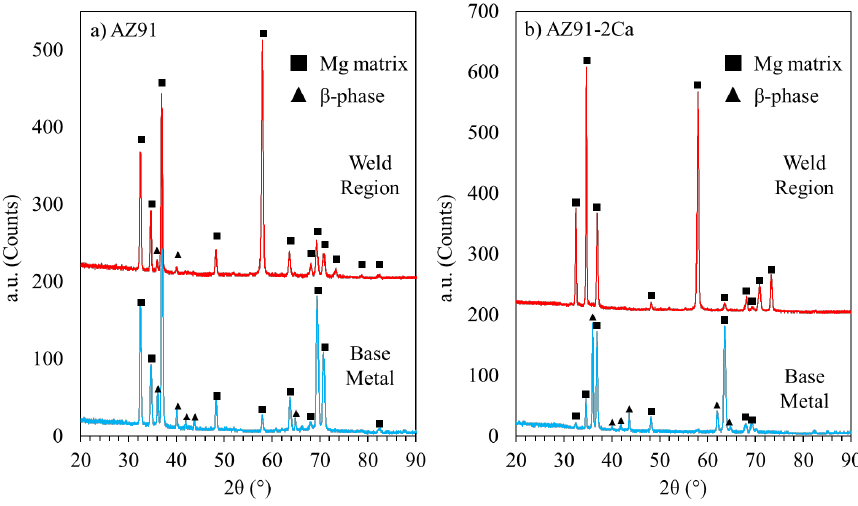
Figure 5. XRD spectra for both the central weld zone and base material in ( a ) AZ91/AZ91 and ( b ) AZ91–2Ca/AZ91–2Ca welds.